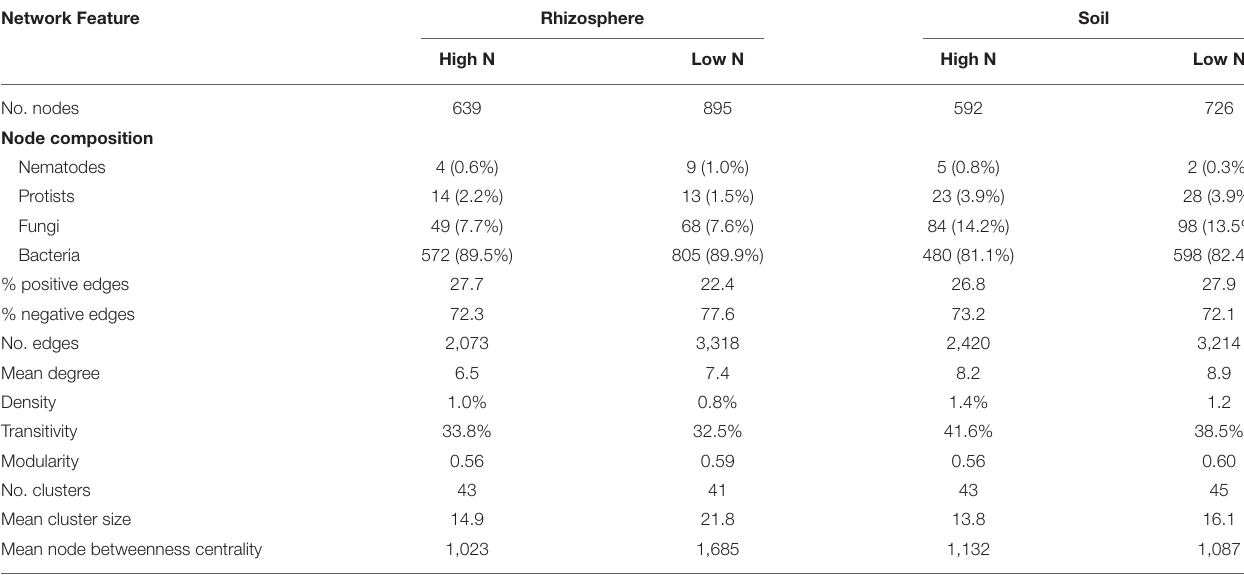
TABLE 5 | Network co-occurrence statistics in the soil and rhizosphere of oilseed rape crops under high and low nitrogen fertilization treatments. Network